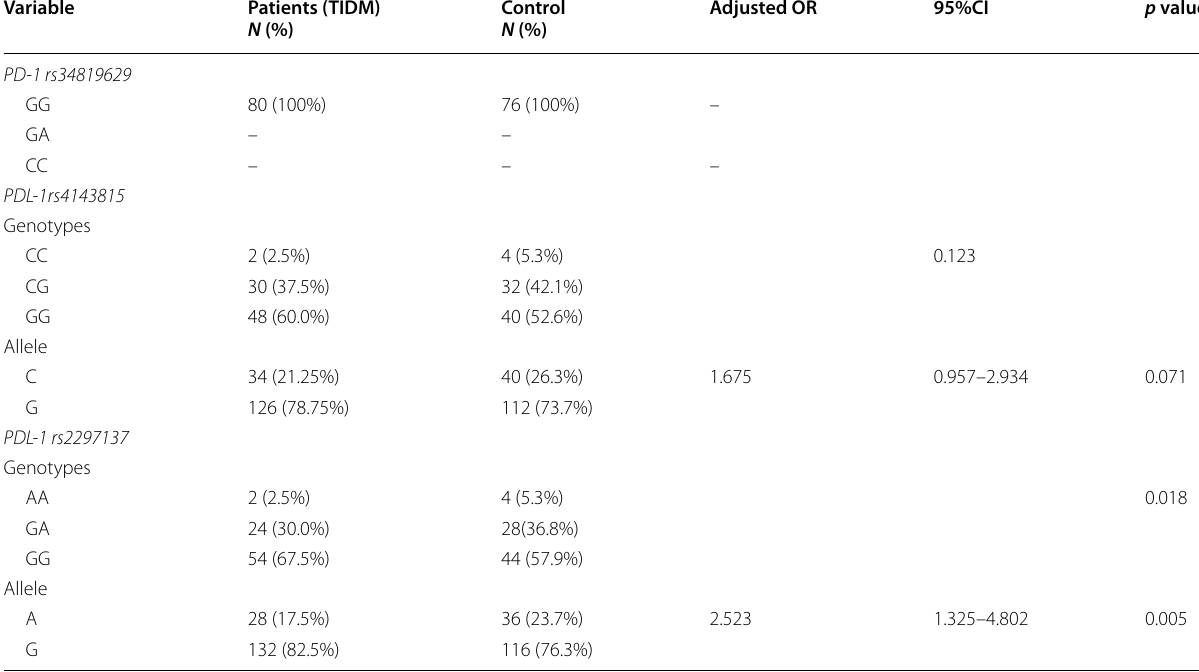
Rs, recognition site; CI, confidence interval; PD-1, programmed cell death protein 1; PDL-1, programmed death-ligand 1; OR, odds ratio * Adjusted for gender, age, and BMI *Analysis of allele frequency distribution was done by the Hardy–Weinberg